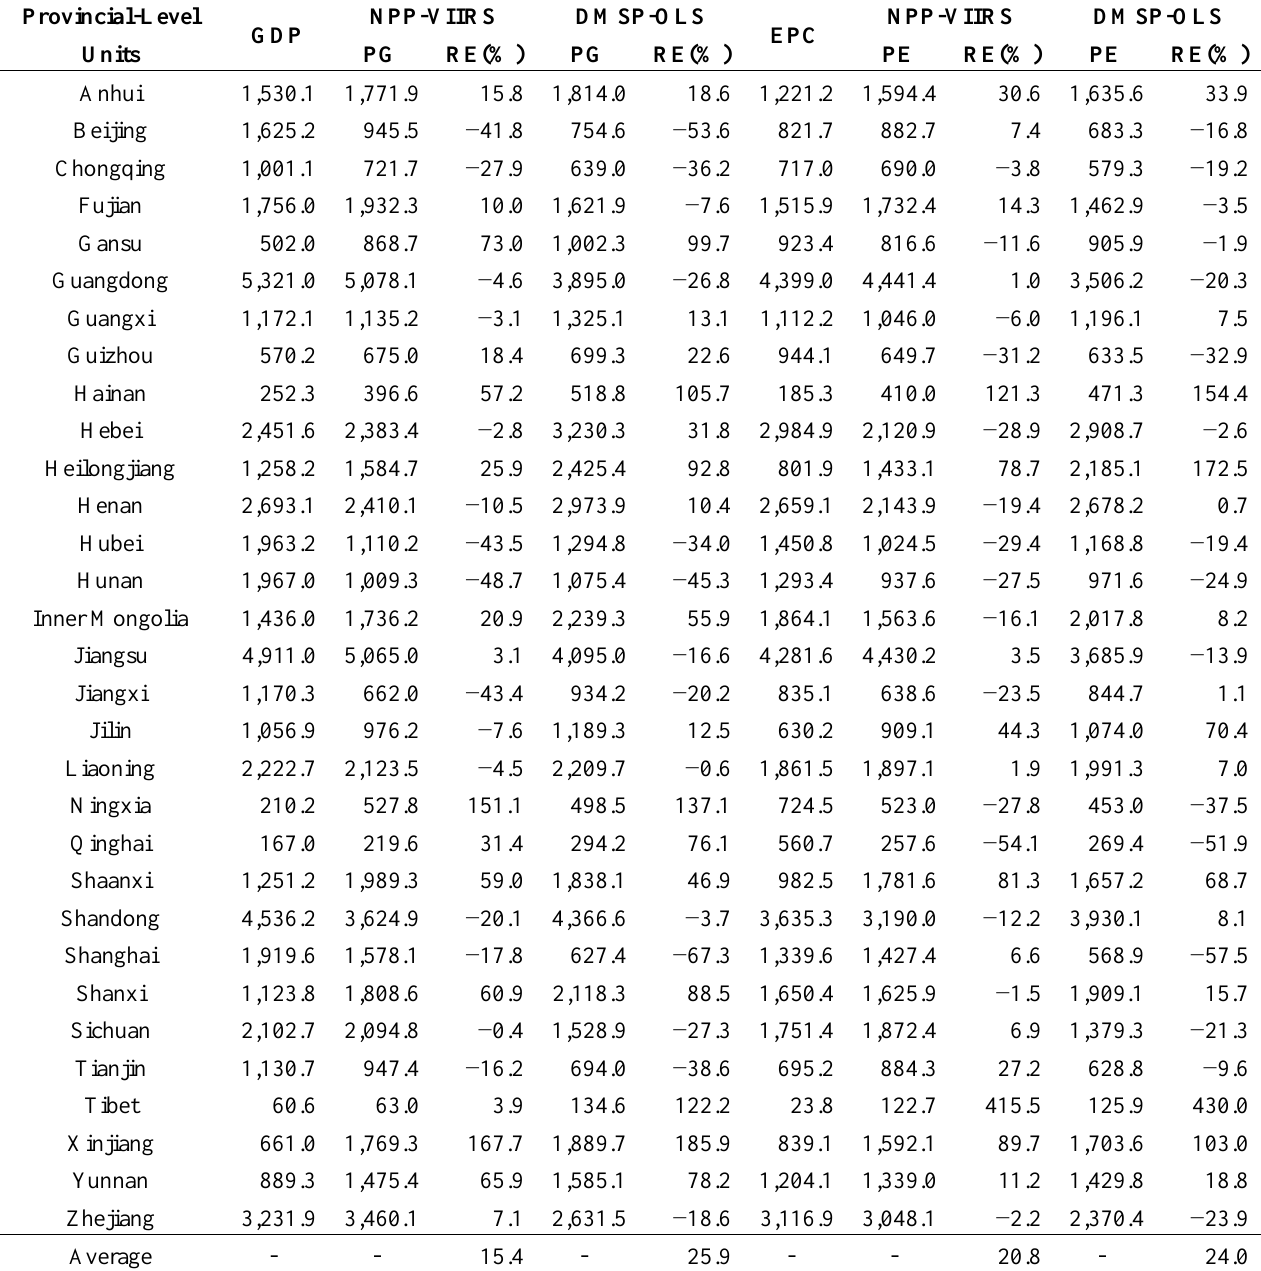
Table 1. Accuracy of the estimated gross domestic product (GDP) and the electric power consumption (EPC) at the provincial level by linear regression analysis. Note: GDP represents the statistical gross domestic product, EPC represents the statistical electric power consumption, PG represents the predicted GDP, PE represents the predicted EPC, and RE represents the relative error in percentage. The unit of the GDP is billion RMB, and the unit of EPC is billion·kilowatt·h −1